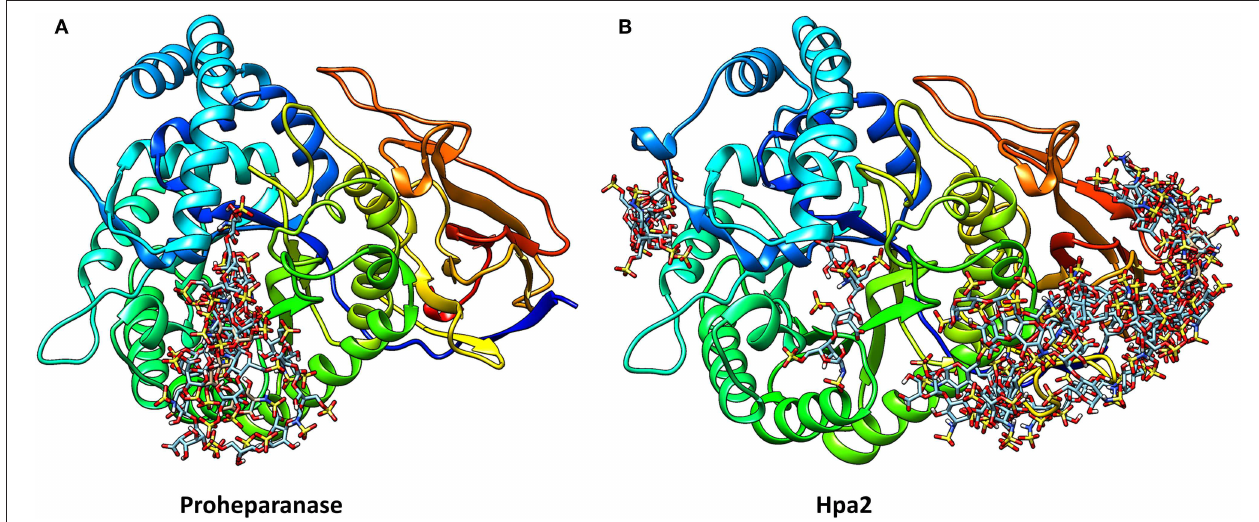
FIGURE 4 | The structures of proheparanase (A) and Hpa2 (B) are shown in ribbon representation and colored from N- (blue) to C- terminal (red). Prediction of heparin tetrasaccharide binding site using the ClusPro server suggests that most of the tetrasaccharides interact with residues 270–280 in proheparanase, whereas most of the interactions with the tetrasaccharides are concentrated toward the C-terminal domain of Hpa2.